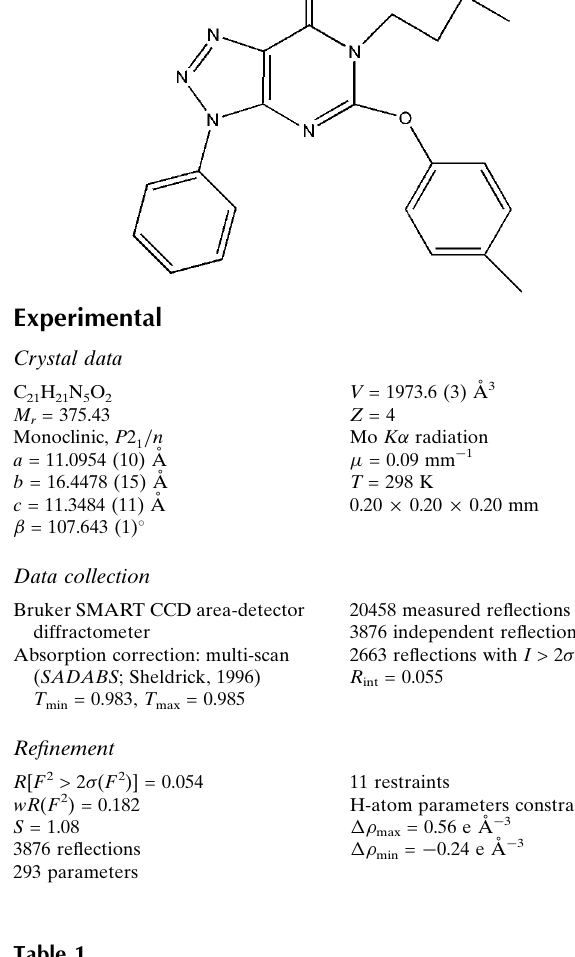
Hydrogen-bond geometry (A˚ , (cid:2)